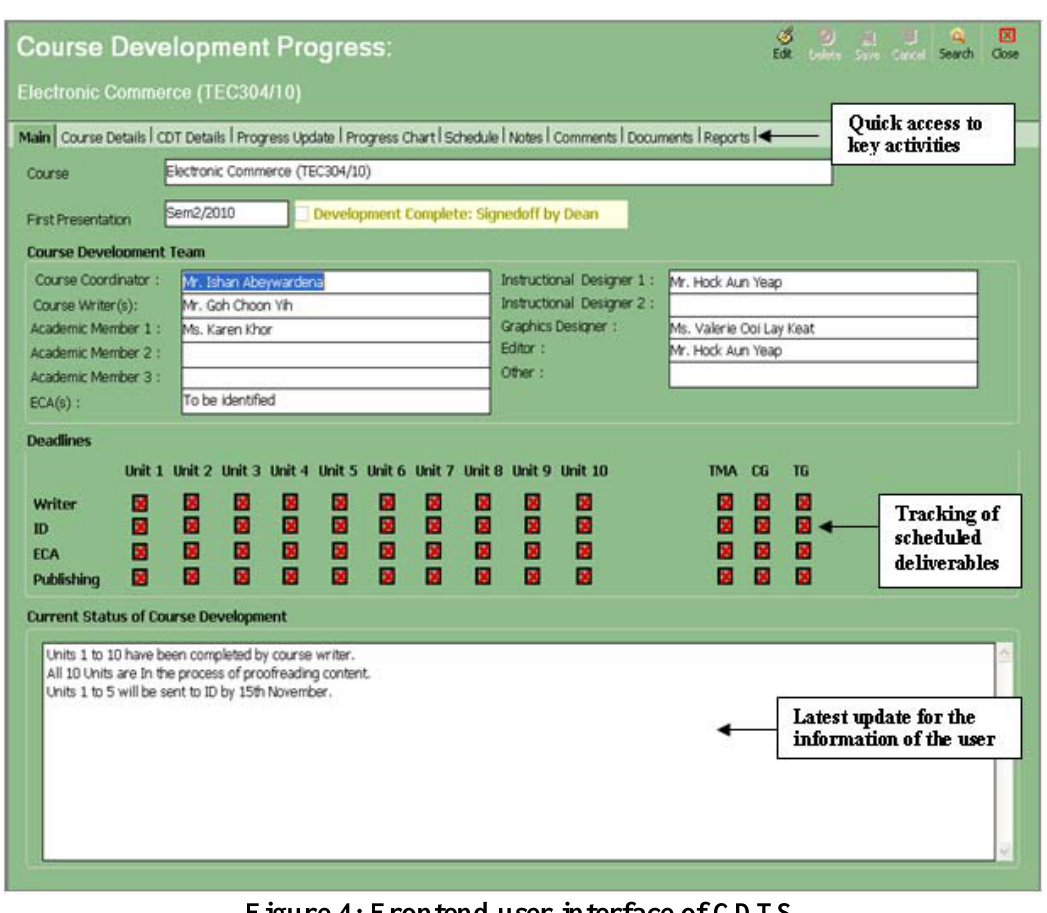
Figure 4: Frontend user interface of